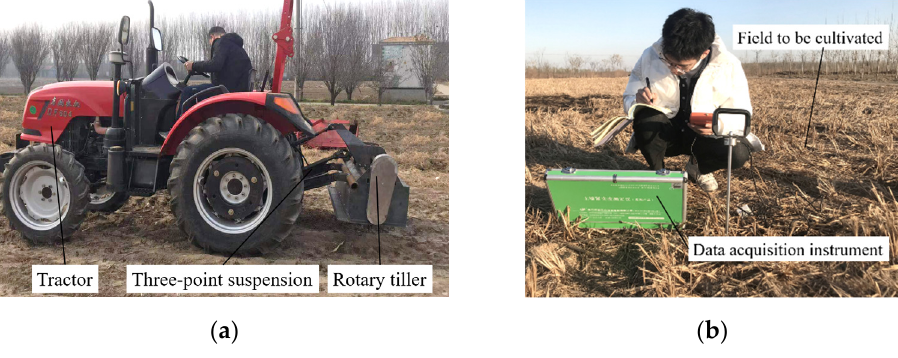
Figure 14. Field experiment. ( a ) Test device; ( b ) data acquisition. Table 4. Test conditions at field experiment site.